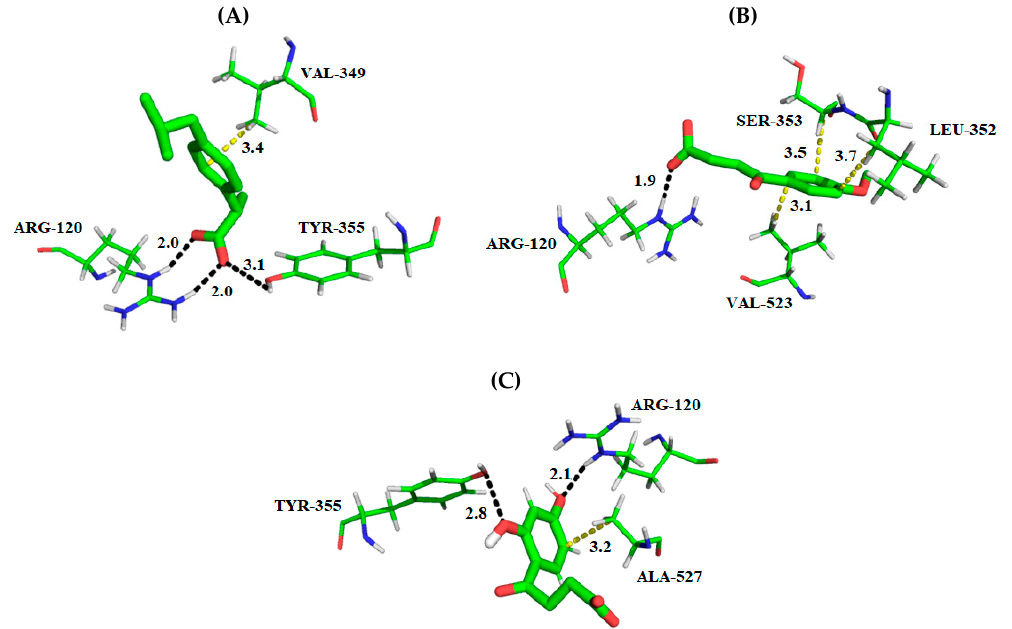
Figure 3. 3D Interaction maps (distances Å) of derivative compounds and crystallographic ligand with a COX-2 active binding site; ( A ) experimental binding profile of ibuprofen, ( B ) best ranked pose of MBPA and the ( C ) best ranked pose of DHBPA. The substrate site residues are depicted in lines, whereas compounds are depicted in the stick model. The hydrogen bonds are displayed as black dashed lines and hydrophobic interactions in yellow dashed lines. All distances are measured in angstroms. Stick: Green = carbon, red = oxygen and gray = hydrogen. Lines: Green = carbon, red = oxygen, gray = hydrogen and blue = oxygen. Figure was generated using the PyMOL 2.2.3 program . In comparison with MBPA, the carboxyl group of compound (docking score = 48.79) made a hydrogen bond with the guanidinium group of Arg120 (donor; α -helix located). While the aryl group made hydrophobic interactions with Leu352 and Ser353 ( β -sheet located) and Val523 ( α -helix located). The hydroxyls of aromatic group of DHBPA (Docking score = 42.04) made a hydrogen bond with the guanidinium group of Arg120 (donor) and phenol group of Tyr355 (acceptor, β -sheet